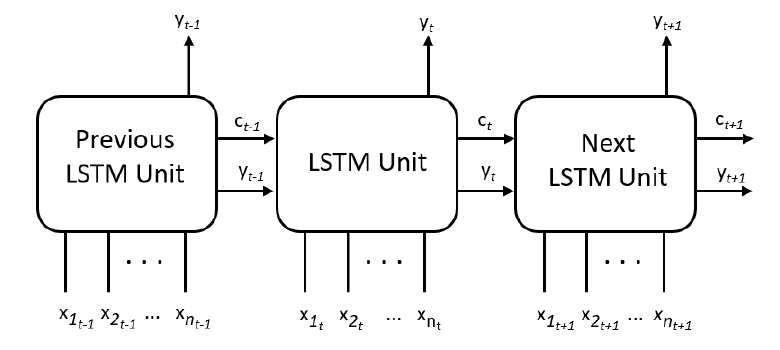
Figure 3. LSTM Multivariate. It is composed of several inputs ( n represents the number of inputs) and a single output. The first input is the one predicted in the output, as it happens in the univariate